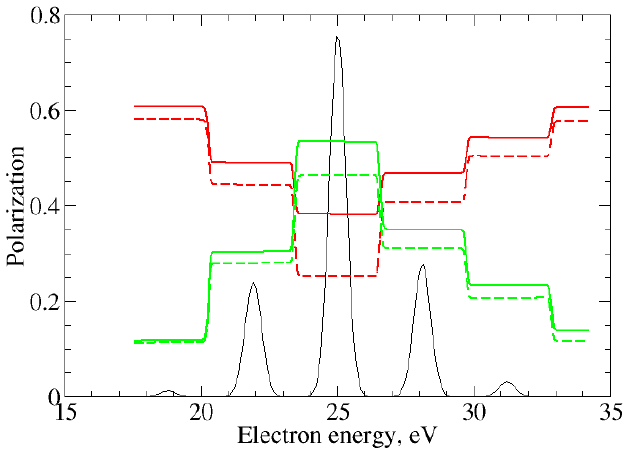
Figure 4. Total spin polarization P 1/2 z (solid lines) and spin polarization at 90 ◦ (dashed lines) at the XUV photon energy of 38.4 eV. Red lines: left-circularly polarized OP, green lines: right-circularly polarized OP. The IR intensity is 5.0 10 12 W/cm 2 . The thin solid line shows the electron spectrum × in arbitrary